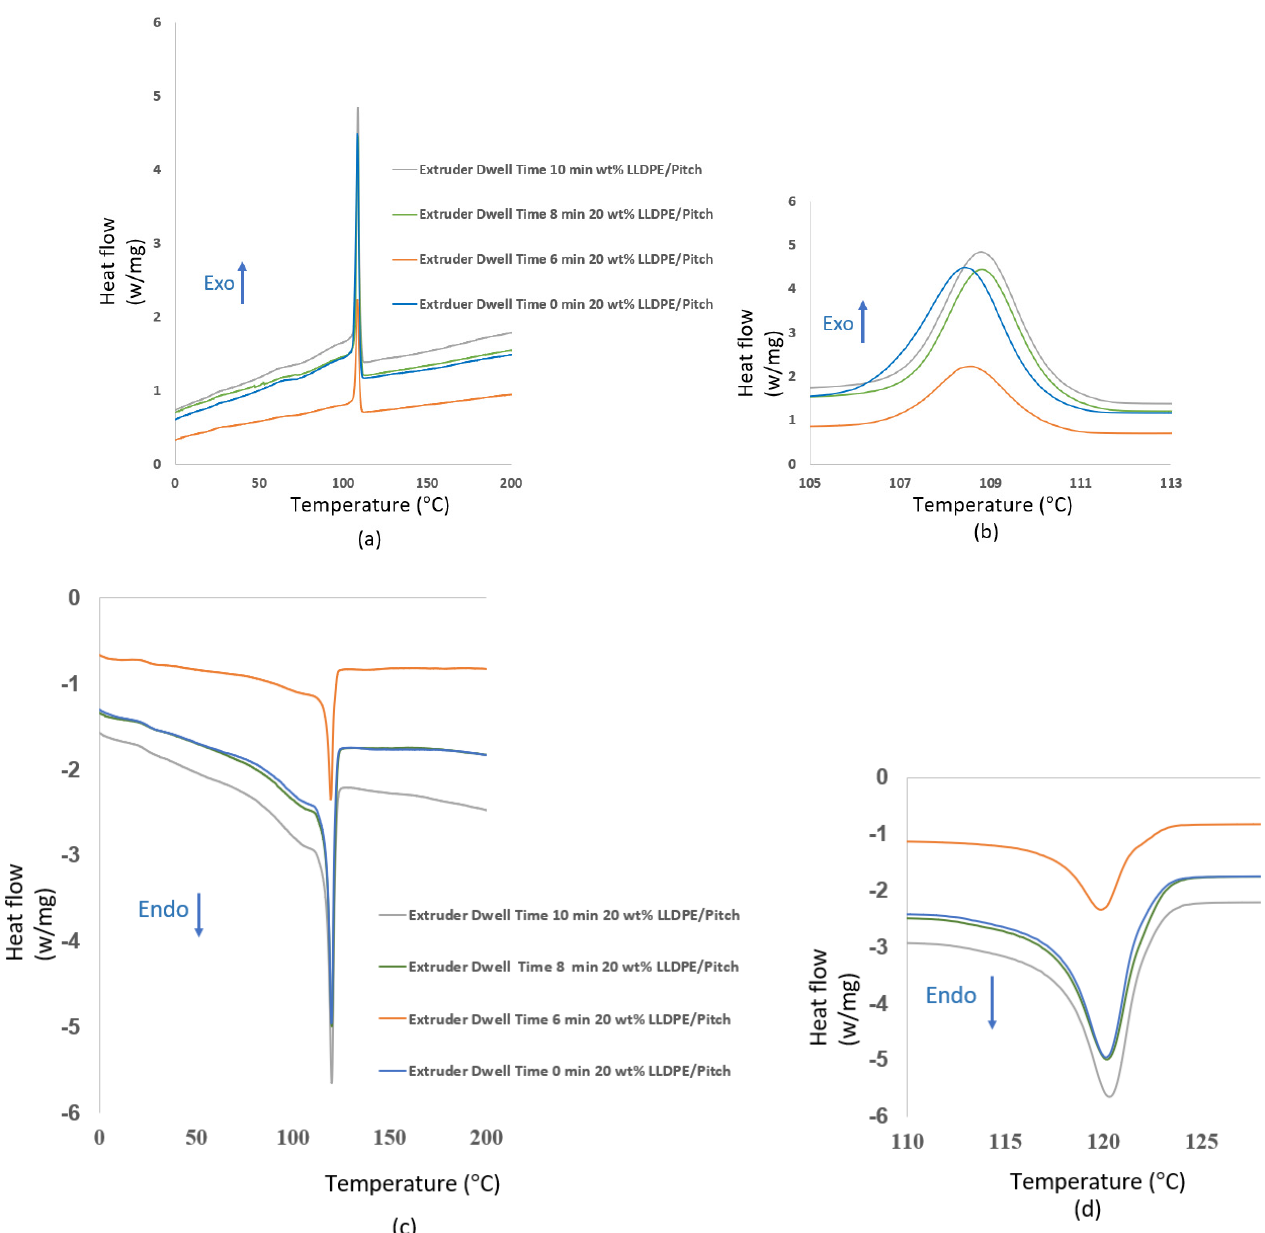
Figure 6. ( a , b ) Exothermal heat flow vs. temperature for crystallisation of LLDPE/MP sample and ( c , d ) endothermic heat flow for melting of LLDPE/MP sample. Four different extrusion dwell times. (Enthalpy of crystallisation, ∆ H c , and enthalpy of fusion, ∆ Hm, are the areas under the respective curves).